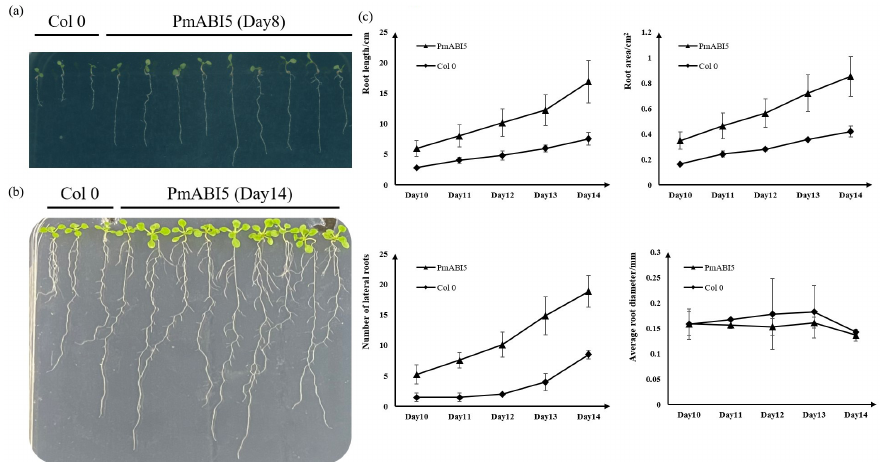
Figure 8. Identification of root traits of PmABI5 Arabidopsis overexpressing transgenic lines. ( a ) OE: PmABI5 Root Phenotype on Day 8 of germination. ( b ) OE: PmABI5 Root Phenotype on Day 14 of germination. ( c ) Mean values of OE: PmABI5 root length, number of lateral roots, root surface area,